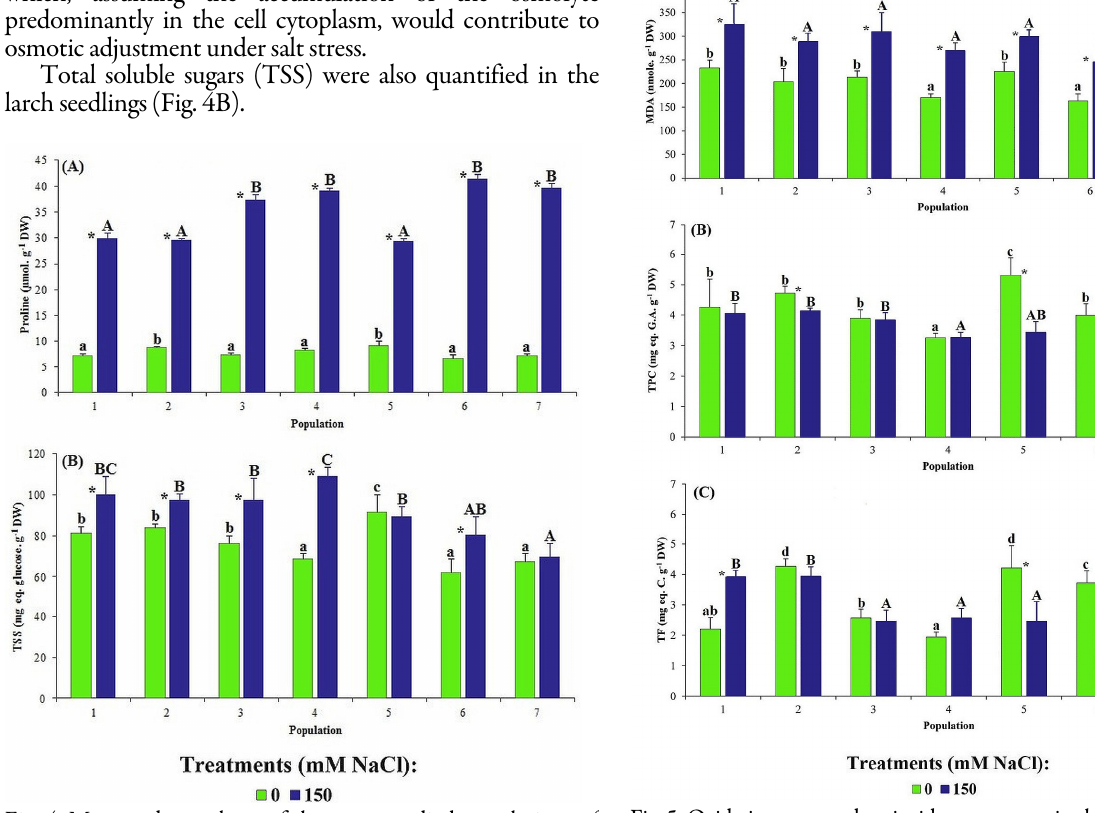
Fig. 4. Measured osmolytes of the seven studied populations of Romanian larch. (A) Proline (Pro) contents expressed in µmol g -1 DW; (B) Total Soluble Sugars (TSS) contents expressed as mg eq. of glucose g -1 DW. Values shown are means ± SE (n = 5). Different letters over the bars (lower case for controls and capital letters for salt stressed plants) indicate significant differences between different populations according to Tukey test (α = 0.05). Asterisks (*) indicate significant differences between salt-treated and control seedlings of the same population. Populations are given number codes according to